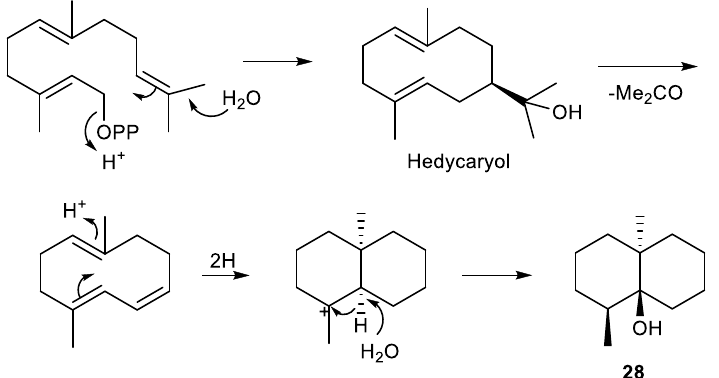
Figure 13. Biosynthesis of geosmin ( 28 ) in the liverwort Fossombronia pusilla. The first characterized geosmin synthase was isolated from Streptomyces coelicolor A3(2) [290,292,297]. Expression in Escherichia coli of the SCO6073 and SC9B1.20 genes gave main converted FDP into a 85:15 mixture of (4 S ,7 R )-germacra-1(10) E , 5 E -diene-11-ol ( A )